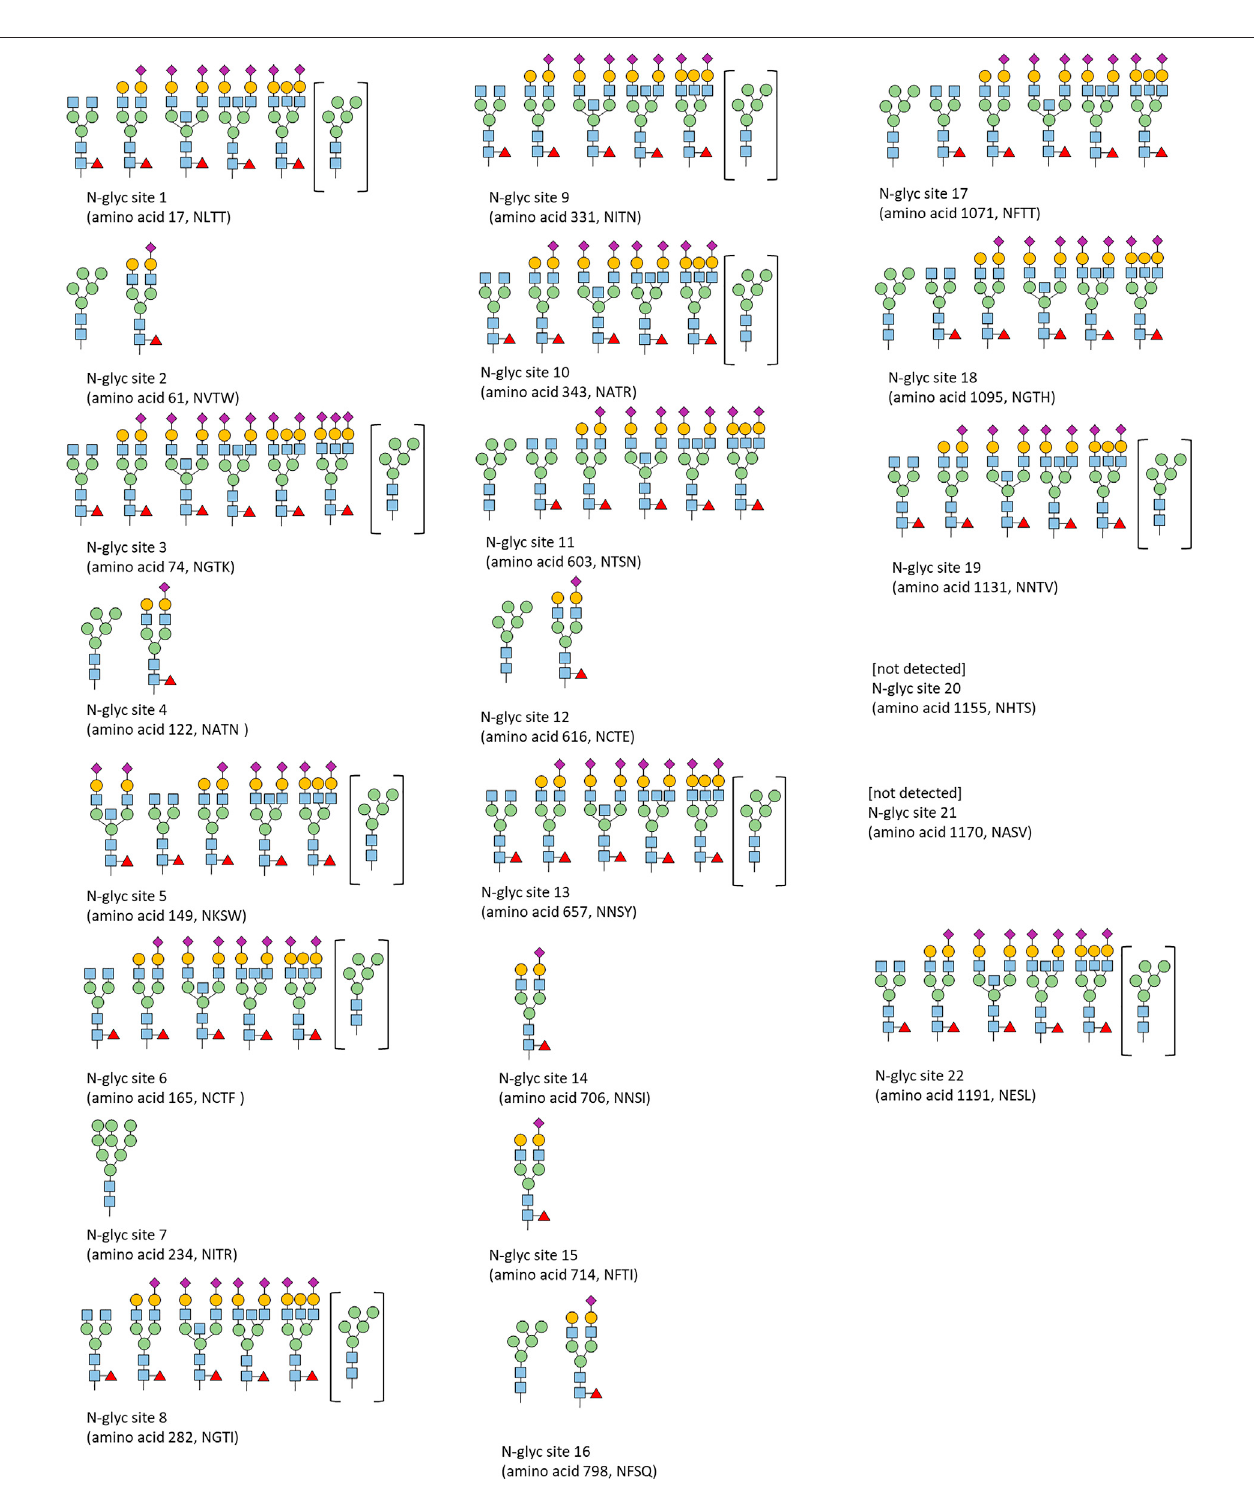
FIGURE 9 | Qualitative N-glycosylation analysis of CSs spike protein by LC-ESI-MS/MS.